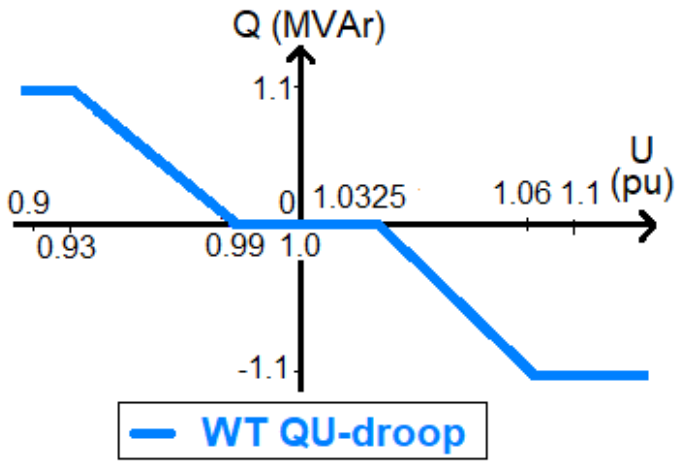
Figure 7. Droop curve tested during studies for the Sundom pilot site, presented in